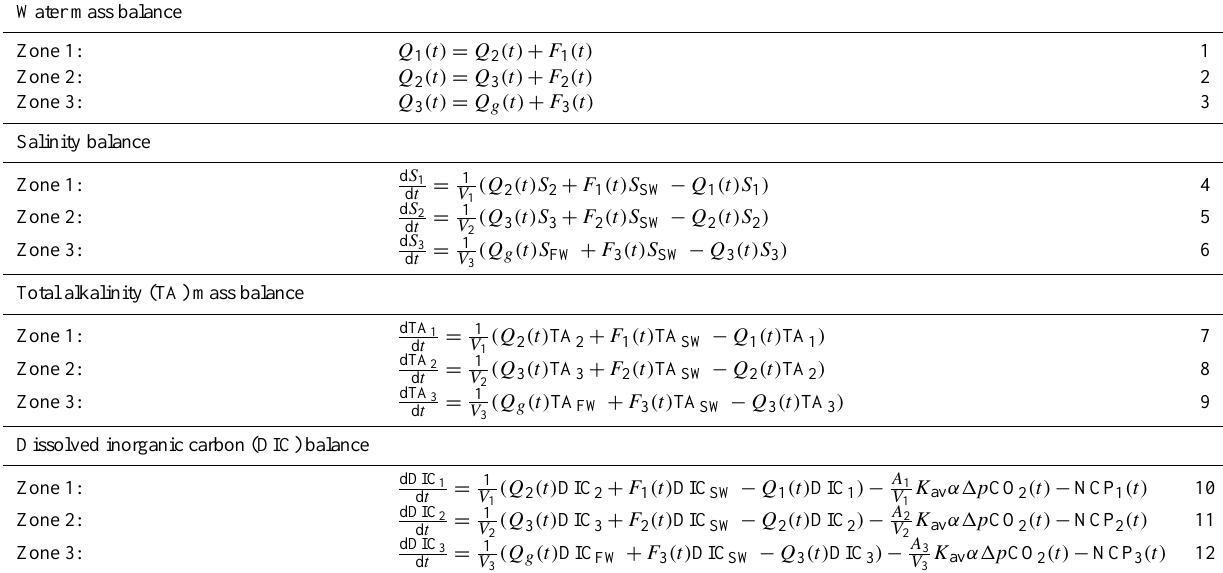
Table 1. Mass balance equations of the biogeochemical model. V i and A i are respectively the volumes and areas of the different zones. (cid:49)p CO 2 is the difference in p CO 2 of the water (modeled) and the atmospheric p CO 2 (400µatm), with negative values implying an uptake by the sea. α is the CO 2 solubility (molm − 3 atm − 1 ). K av (ms − 1 ) is the gas transfer coefficient calculated using the formulation of Nightingale et al. (2000). NCP is the net community production. The glacial meltwater input into the fjord Q g (t) is imposed as a forcing function upon the model – see material and methods for details how Q g (t) is parameterized as a function of time. Water mass